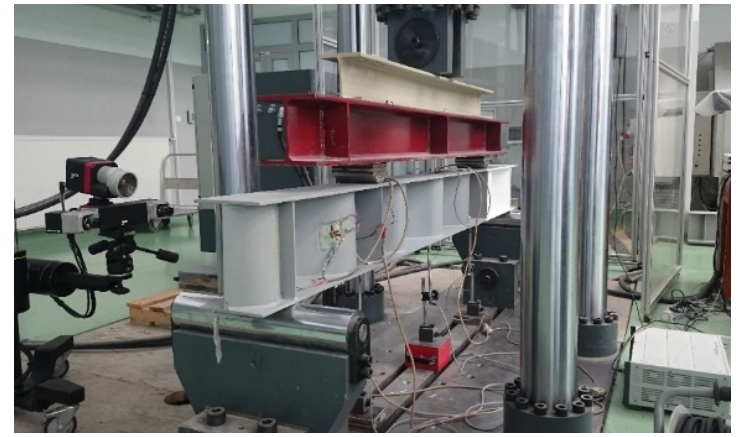
Figure 7. Example of a test sample set up on the test stand.